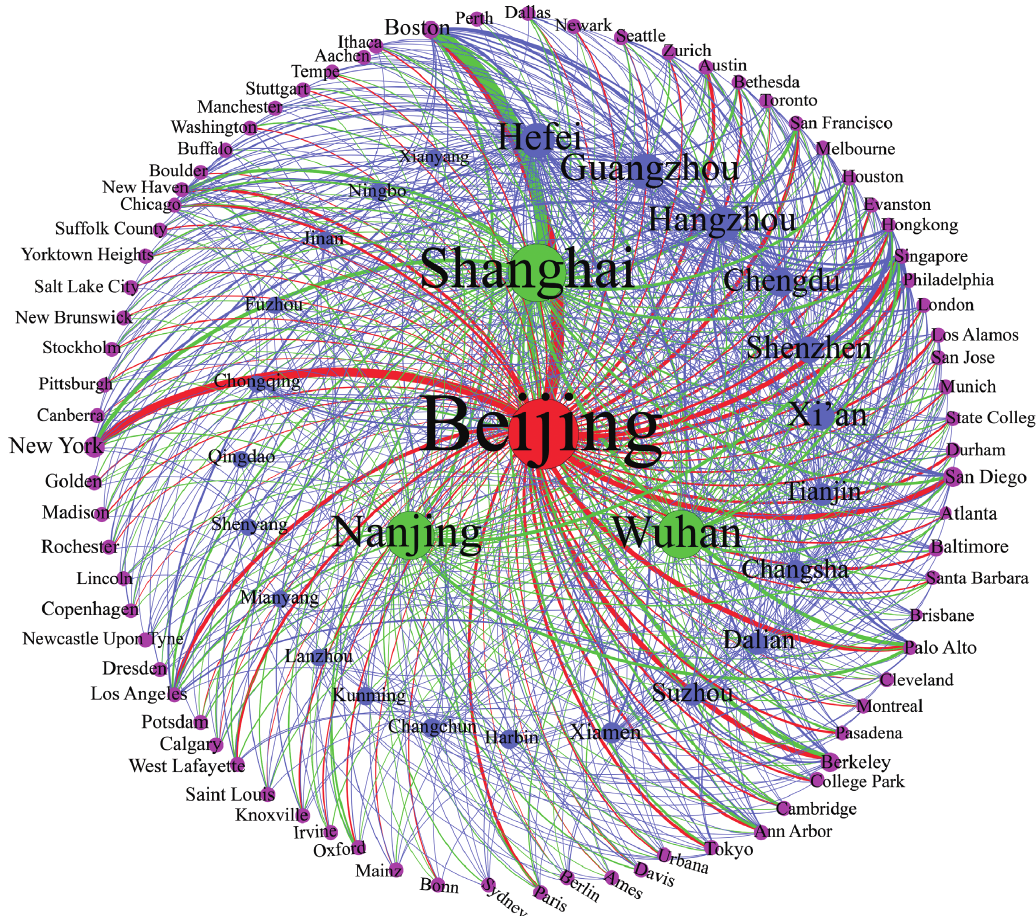
Figure 2: Centrality visualization of the global city from 2011 to